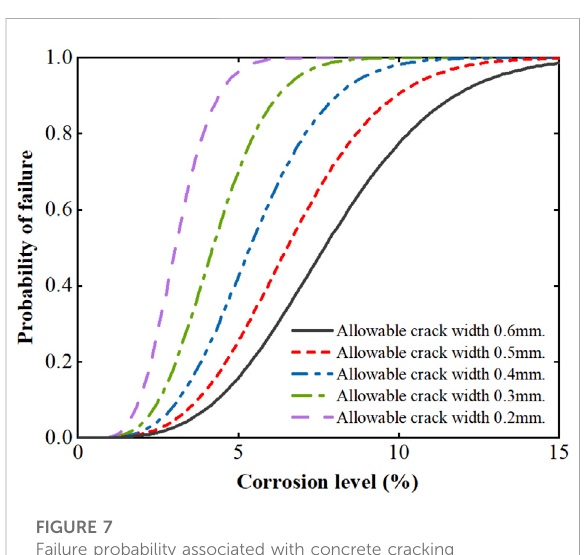
FIGURE 7 Failure probability associated with concrete cracking evolution for various allowable crack width limits.